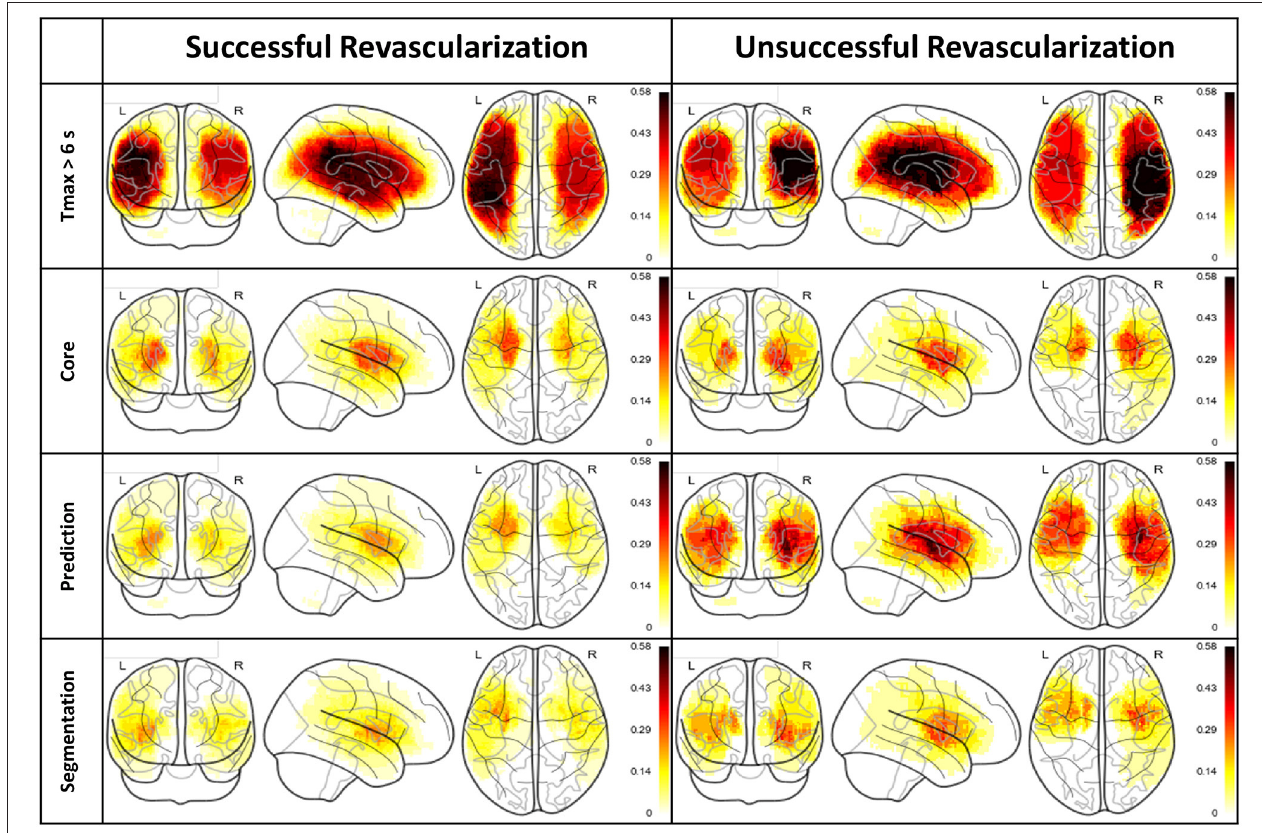
FIGURE 3 | Lesion distributions horizontally and vertically grouped by revascularization outcome and type of lesion delineation, respectively. The distributions are normalized so that the values are confined to the range 0 (i.e., not affected by any lesion in the cohort) and 1 (i.e., affected by all lesions in the cohort).